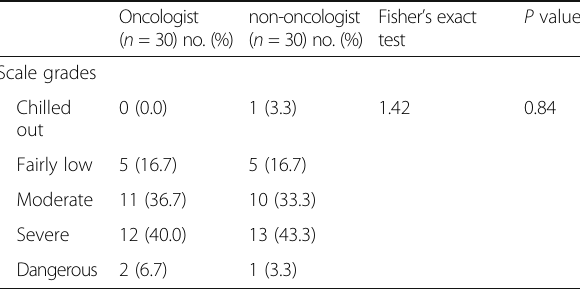
Table 2 Distribution of workplace stress scale grades in the groups